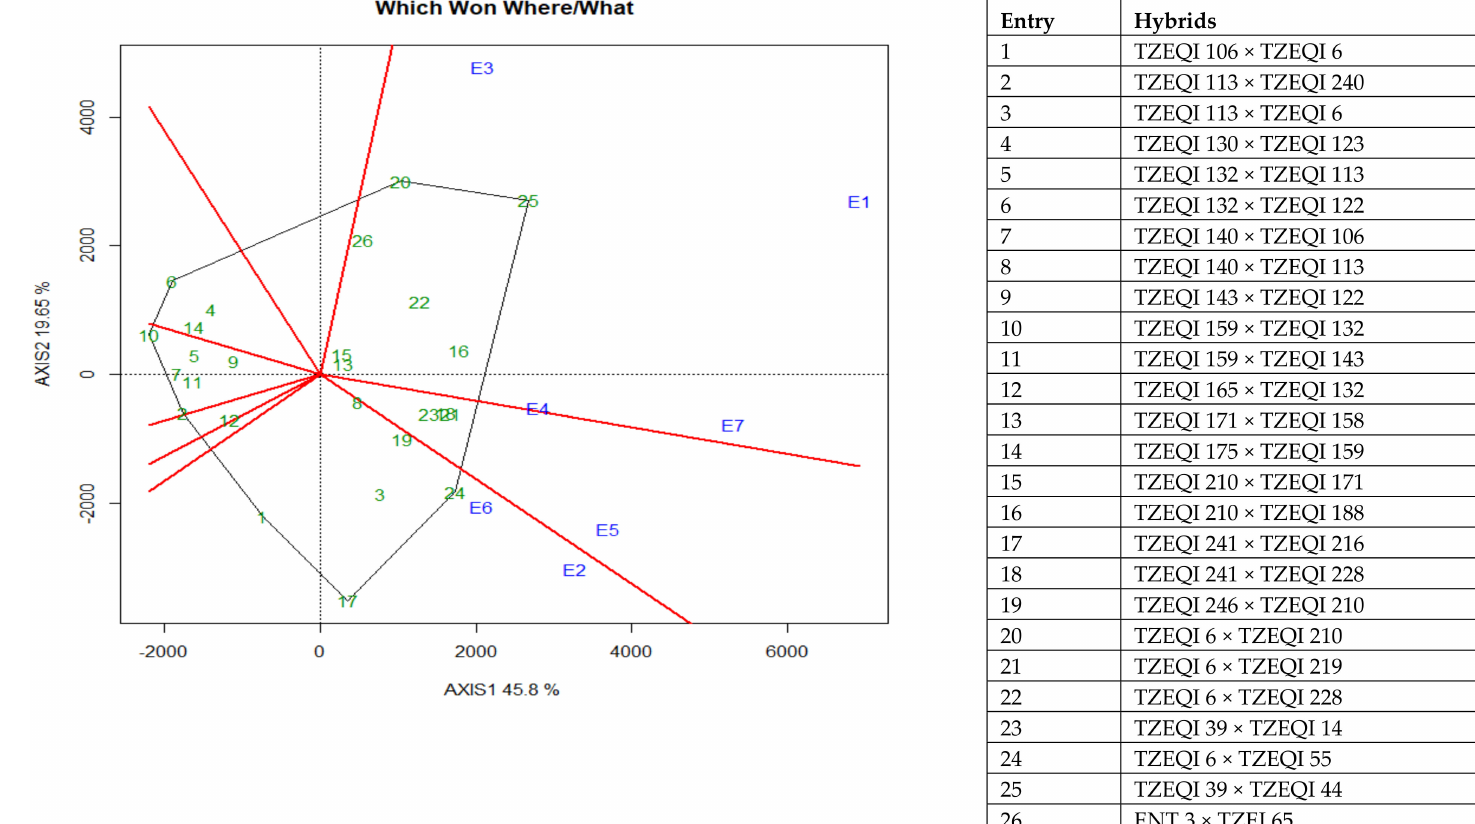
Figure 3. A “which won where” genotype plus genotype by environment interaction biplot of grain yield of selected 22 early QPM hybrids plus checks based on CDHS and the low-nitrogen base index evaluated across CDHS, low N and optimal environments 2019 and 2021. E1 = Mokwa under low-nitrogen environment, 2019, E2 = Mokwa under low-nitrogen environment, 2020, E3= Mokwa under optimal environment, 2019, E4 = Mokwa optimal environment, 2020, E5 = Kadawa optimal environment, 2020, E6 = Kadawa under CDHS environment, 2020, E7 = Kadawa under CDHS environment,